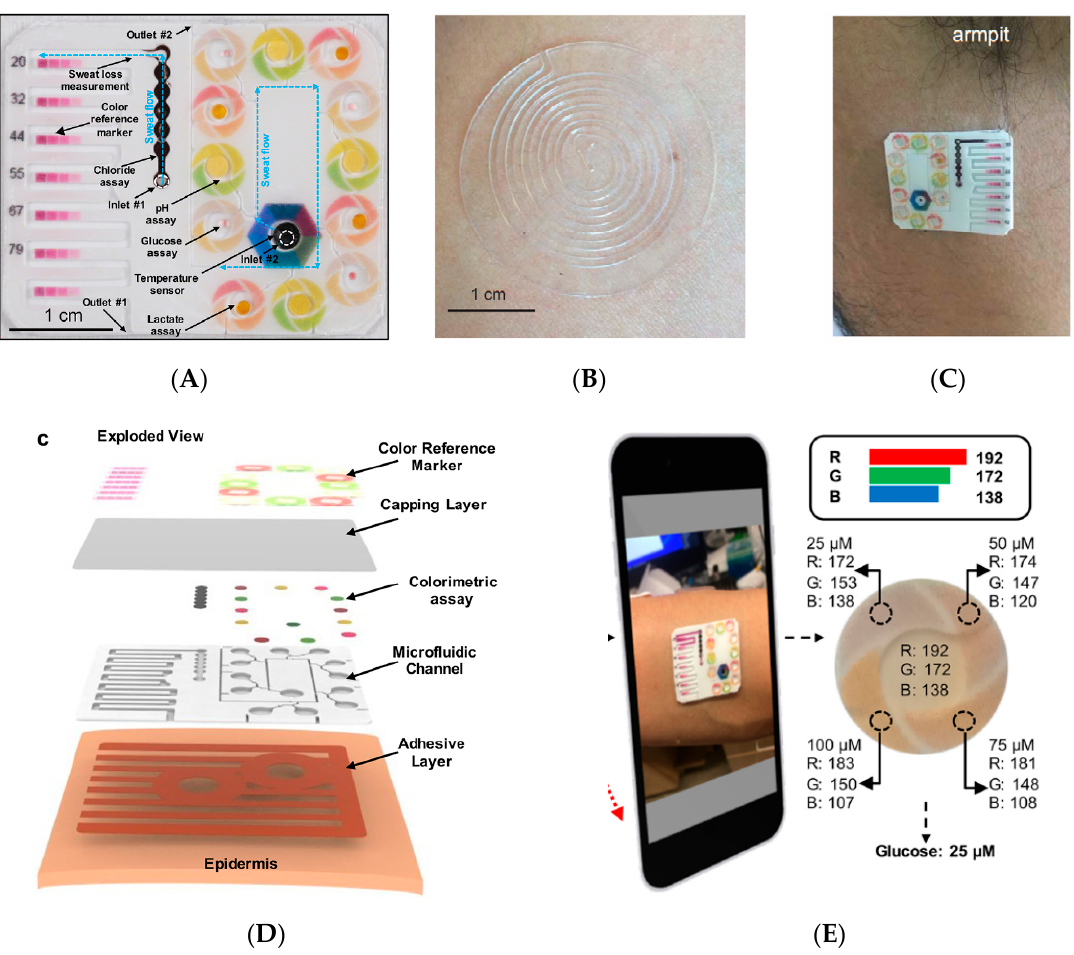
Figure 2 . ( A ) PMMA patch onto which the microfluidic channels and reservoir are engraved. The printed patterns are used as visual references. ( B ) Soft PDMS patch for collecting sweat. The width and depth of the coiled channel are 1 mm and 300 μ m, respectively. ( C ) Patch placed close to the armpit. Some sweat (internally mixed with a dark dye) started to flow. ( D ) Exploded view of the patch. ( E ) Example of data transmission by image treatment using a smartphone. Reproduced from [28] with